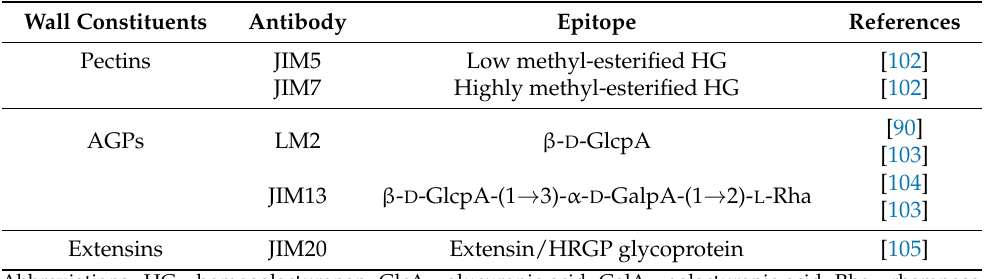
Table 1. Primary antibodies used for the detection of cell wall